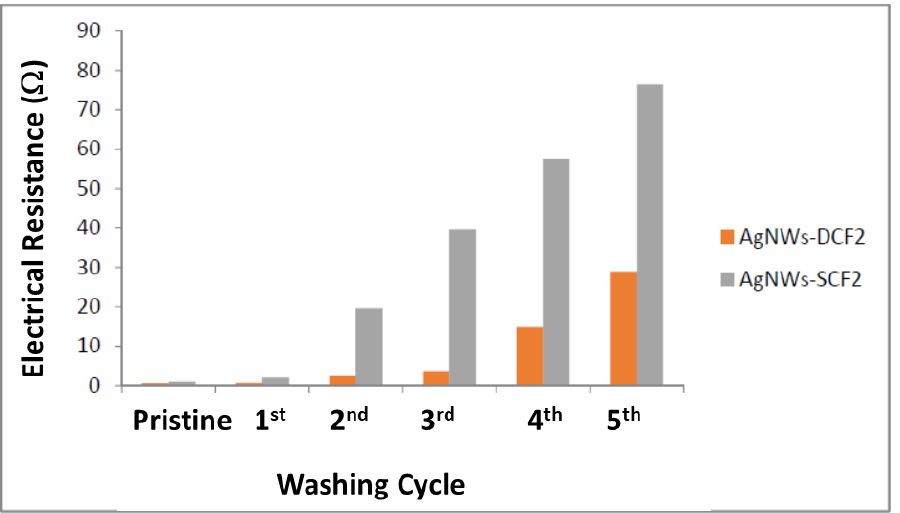
Figure 6. The electrical resistance of the AgNWs coated fabric by dip and spray coating method, before and after cyclic washing for up to 5 cycles of washing.